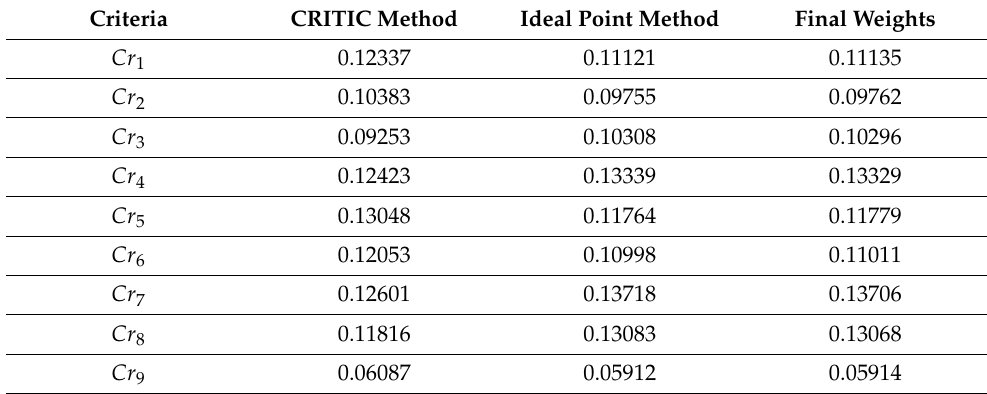
Table 11. Weights of criteria.